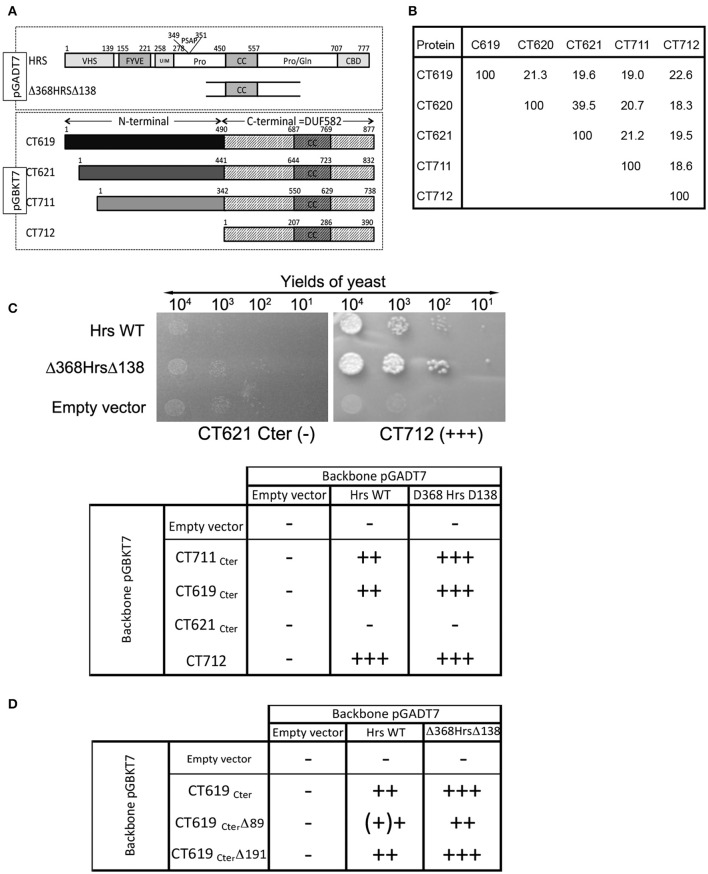
Interaction between the DUF582 and Hrs probed by two-hybrid in yeast. (A) Schematic view of the constructs used. Full length Hrs, or the minimal domain interacting with CT619 identified in the two-hybrid screen, Δ368HrsΔ138, were cloned in the pGADT7 vector. For the four chlamydial proteins tested, only the corresponding DUF582 (hatched box) were cloned in the pGBKT7 vector. (B) Percentage of identity between amino acids within the DUF582 domain of C. trachomatis DUF582 proteins (C) Illustration of one negative (CT621Cter) and one positive (CT712) interaction, and summary of the yields of yeast observed in the different combinations tested. (D) Summary of the yields of yeast observed when the last 89 or 191 amino acids of CT619Cter were deleted.